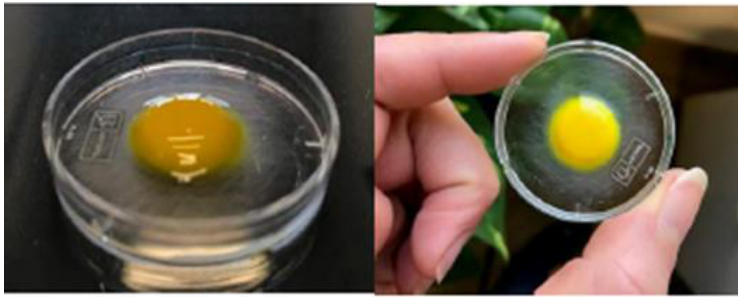
Figure 3. Swelling index measured as percent of weight increased vs. time. Values are presented as means ± SE ( n = 9).